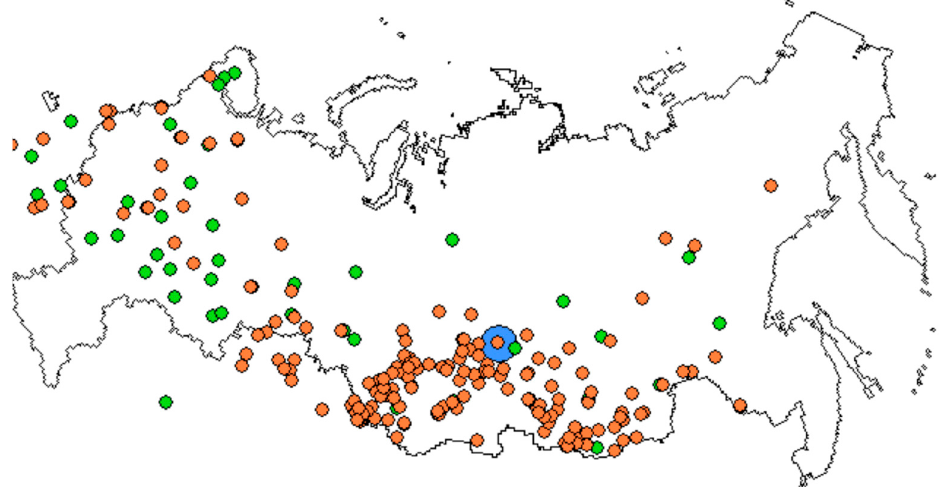
Figure 1. The distribution of 42 P. sylvestris provenances across Russia (green points) that were used in our common garden trial in the test site of the Boguchany settlement (blue circle), central Siberia. All 166 provenances (green and red points) were used to construct our bioclimatic seed mass model.